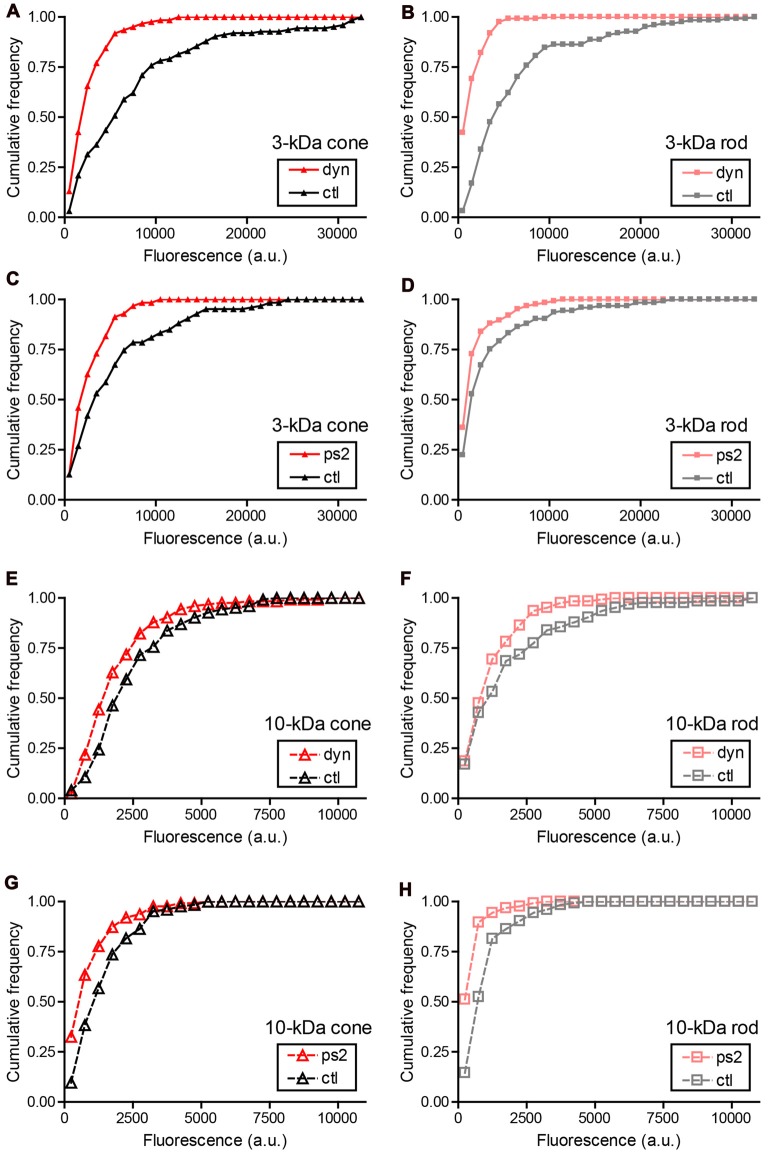
Sensitivity of small and large dyes to endocytic inhibitors. Cumulative frequency histograms of whole-terminal fluorescence measured in rods and cones after incubation with 3-kDa or 10-kDa Texas Red. Retinas were incubated for 20 min in a test solution (dynasore, pitstop-2, or vehicle control) and then another 10 min in test solution supplemented with 3-kDa (67 μM) or 10-kDa Texas Red (50 μM). Retinal cells were then isolated and plated onto coverslips. Data in each condition were obtained from multiple cells in three replicate experiments. (A) Cones loaded with 3-kDa Texas Red and treated with dynasore (80 μM, N = 122 cells) or vehicle control (0.1% DMSO, N = 124). The cumulative distributions of intraterminal fluorescence differed significantly by a Kolmogorov–Smirnov test (P < 0.0001). (B) Rods loaded with 3-kDa Texas Red and treated with dynasore (N = 123) or vehicle control (N = 124; P < 0.0001, Kolmogorov–Smirnov test). (C) Cones loaded with 3-kDa Texas Red and treated with pitstop-2 (25 μM, N = 126) or vehicle control (0.2% DMSO, N = 126; P < 0.0001). (D) Rods loaded with 3-kDa Texas Red and treated with pitstop-2 (N = 125) or vehicle control (N = 125; P = 0.002). (E) Cones loaded with 10-kDa Texas Red and treated with dynasore (N = 124) or vehicle control (N = 123; P < 0.0001). (F) Rods loaded with 10-kDa Texas Red and treated with dynasore (N = 124) or vehicle control (N = 124; P = 0.035). (G) Cones loaded with 10-kDa Texas Red and treated with pitstop-2 (N = 126) or vehicle control (N = 125; P < 0.0001). (H) Rods loaded with 10-kDa Texas Red and treated with pitstop-2 (N = 125) or vehicle control (N = 124; P < 0.0001).